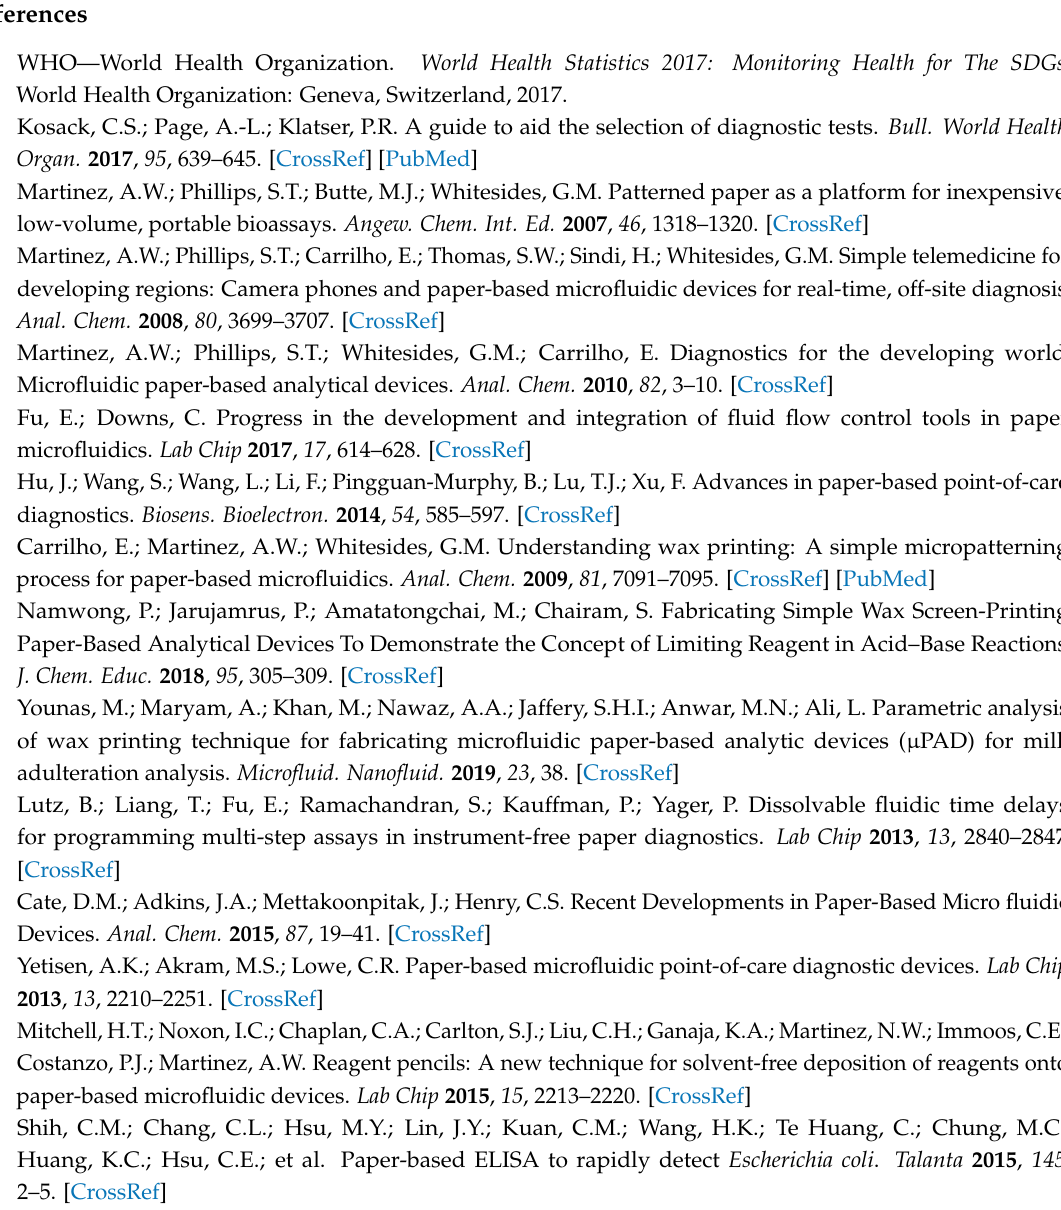
Figure A2. Time lapse images of sequential dye delivery to the test zone in an additional 4-channel (15 × 4 mm) microPAD with differing percentages of wax coverage (25–100%) as compared to Figure 2a–c. Multi-colored dyes were added simultaneously to the loading inlet. The dyes reached the test zone at more similar times as compared to Figure 2a–c. Abbreviations: Obs. means observed, Exp. means expected, * means expected calculated based on the results from Figure 1c & Table A1. The dimensions of the channels and volumes of fluids used in the two experiments were different, however, these values allow for an approximate prediction of wicking time given the channel length and % wax coverage.